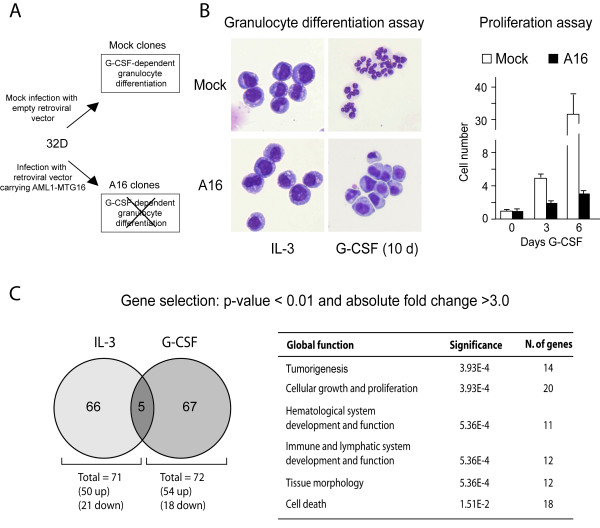
Global gene expression analysis of AML1-MTG16-expressing cells. A. The 32D cell model, comprising clones expressing the AML1-MTG16 protein (A16 clones) and control clones ("mock" clones), which do not express the fusion protein. B. A16 clones, differently from mock clones, do not undergo granulocytic differentiation and display an impaired proliferation in the presence of G-CSF. C. Most of the genes whose expression is significantly affected in A16 cells were found previously implicated in biological processes.